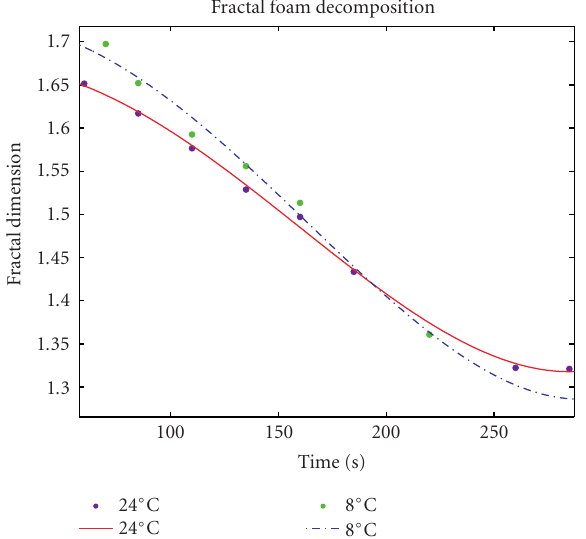
Figure 3.10. The fractal dimension D as function of time for the decomposition of the foam of Beck’s Alkoholfrei beer at various temperatures. The spline functions are given by (3.12).